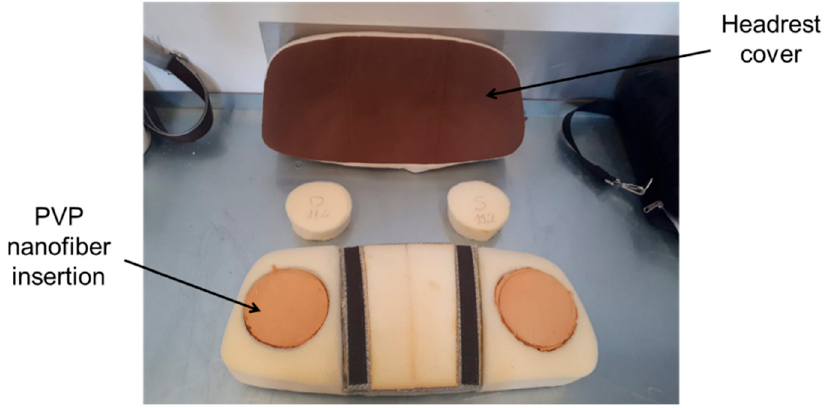
Figure 3. Configurable headrest adopted for the experimental investigations.